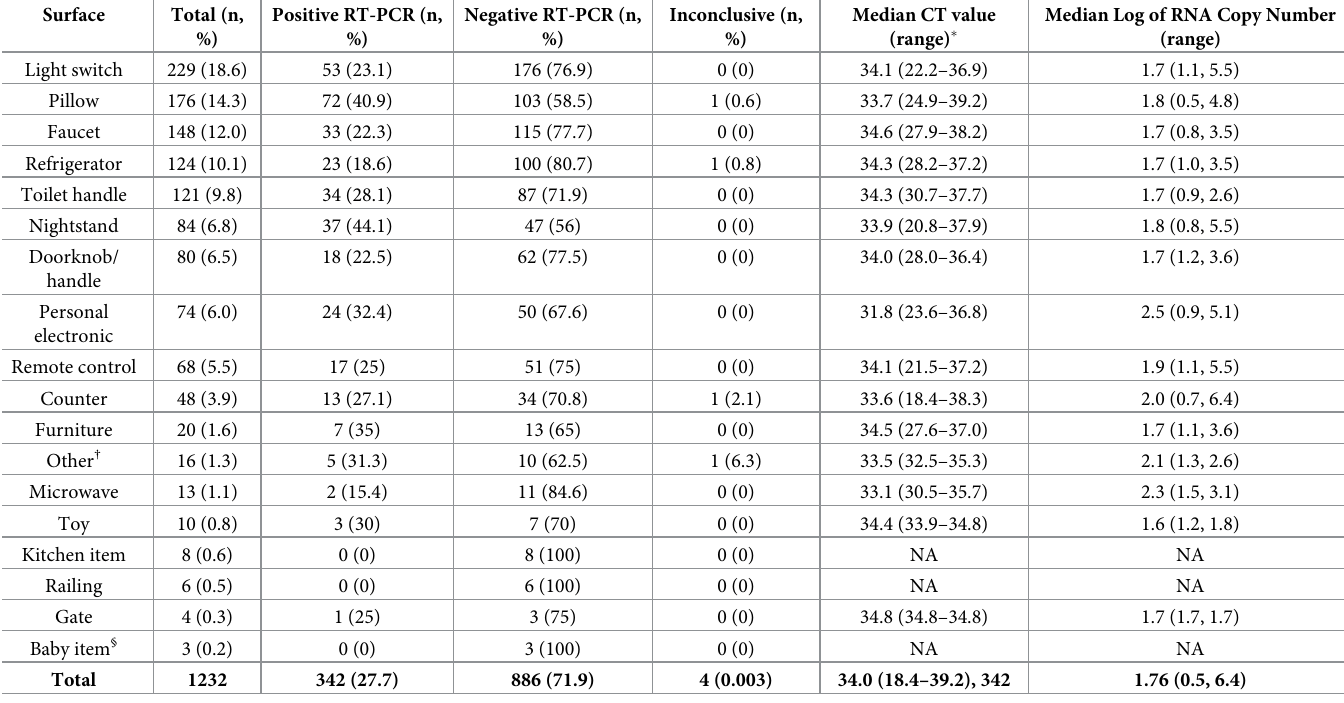
Table 2. SARS-CoV-2 RT-PCR results from environmental sampling of common household surfaces in households with one or more cases of